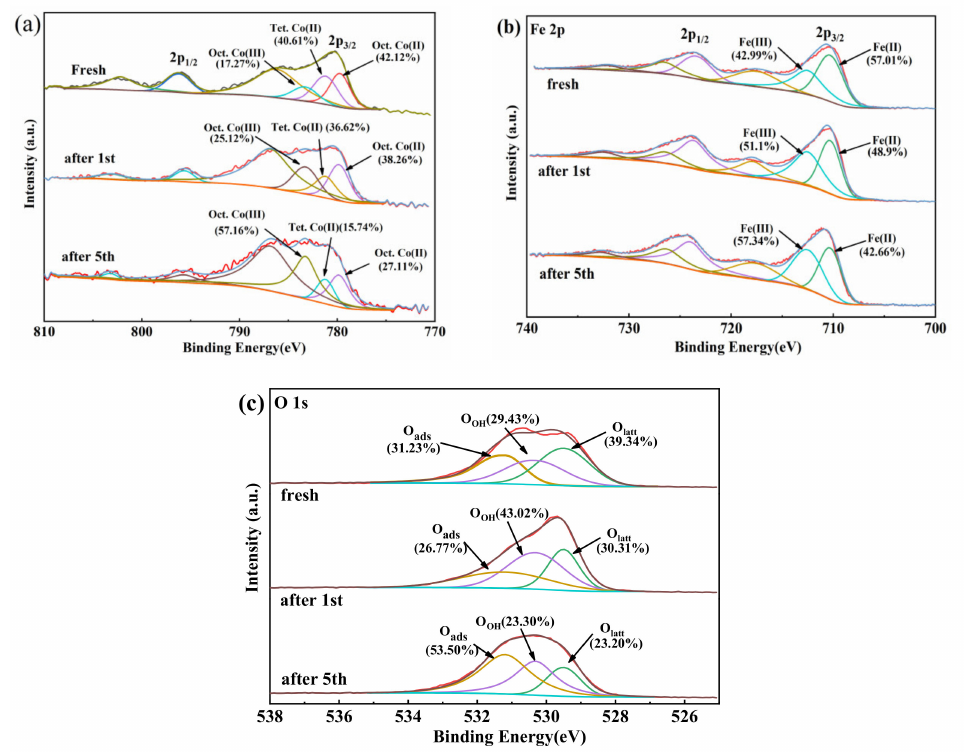
Figure 16. ( a ) Co 2p, ( b ) Fe 2p, and ( c ) O 1s XPS spectra of CoFe 2 O 4 @CNTs before and after